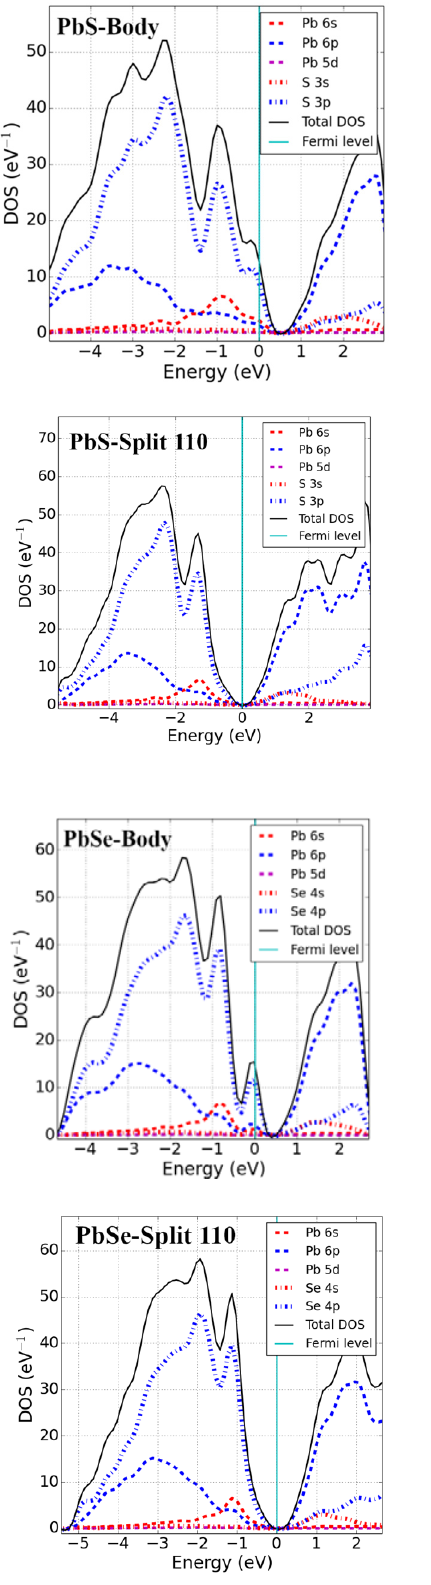
( b ) Figure 2. Final stable configuration of ( a ) base and ( b ) split <110> interstitials in alkali halides. Blue and green atoms are halogens and alkali metals, respectively. Arrows represent the direction of motion and their magnitude represents relative displacements corresponding to nearest neighbor- ing atoms. 3.2. Bandgap and Electronic Properties of Neutral Defects Point defects may change the electronic properties of pristine materials by perturbing the valence band maxima (VBM) and conduction band minima (CBM). We studied the electronic properties of interstitial point defects in selected rock-salt materials, examining